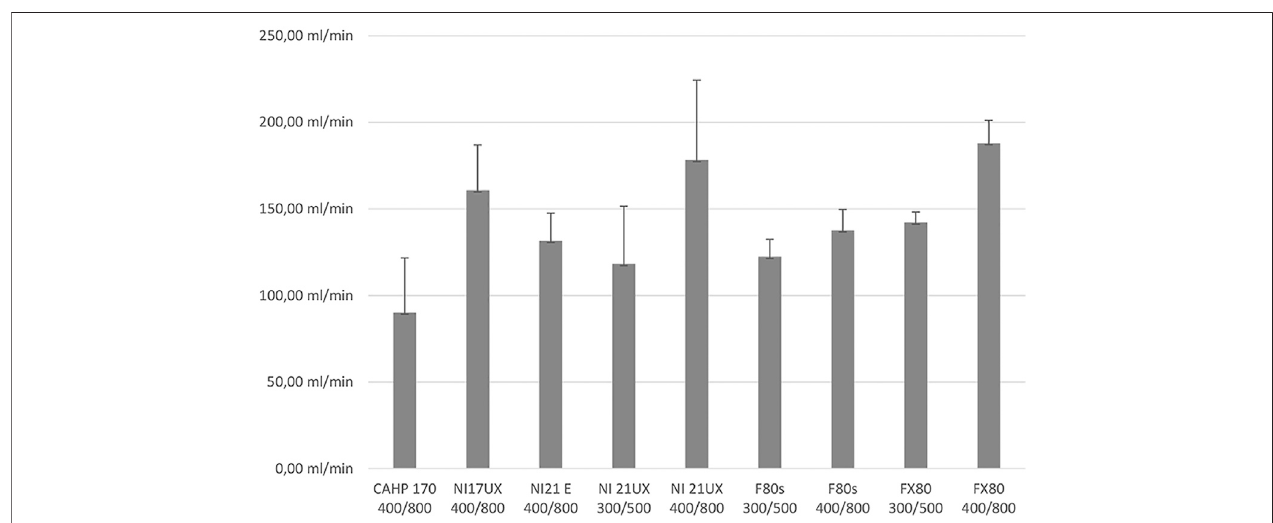
FIGURE 3 | Different Gentamicin clearances found in different membranes and fl ow rates. Membranes: CAHP 170: Baxter high performance cellulose diacetate membrane, 1.7m 2 suracearea; SF17UX:Nipro Sur fl ux-17UX high performancecellulose triacetate membrane,1.7m 2 surfacearea;SF21UX:Niprosure fl ux-21UXhigh performancecellulose triacetate membrane, 2.1m 2 surfacearea;SF21E: Nipro Sure fl ux-21Ebalanced medium- fl ux cellulosetriaceatemembrane, 2.1m 2 surface area; F80s: Fresenius medical care F80s, high fl ux polysulphone membrane, 1.8 m 2 surface area; FX80: Fresenius medical care FX 80classix high fl ux polysulphone membrane, 1.8 m 2 surface area. Flow rates are given below the membrane identi fi er: fi rst number represents blood fl ow in ml/min, second number dialysate fl ow in mL/min. Standard deviation is identi fi ed by whiskers.